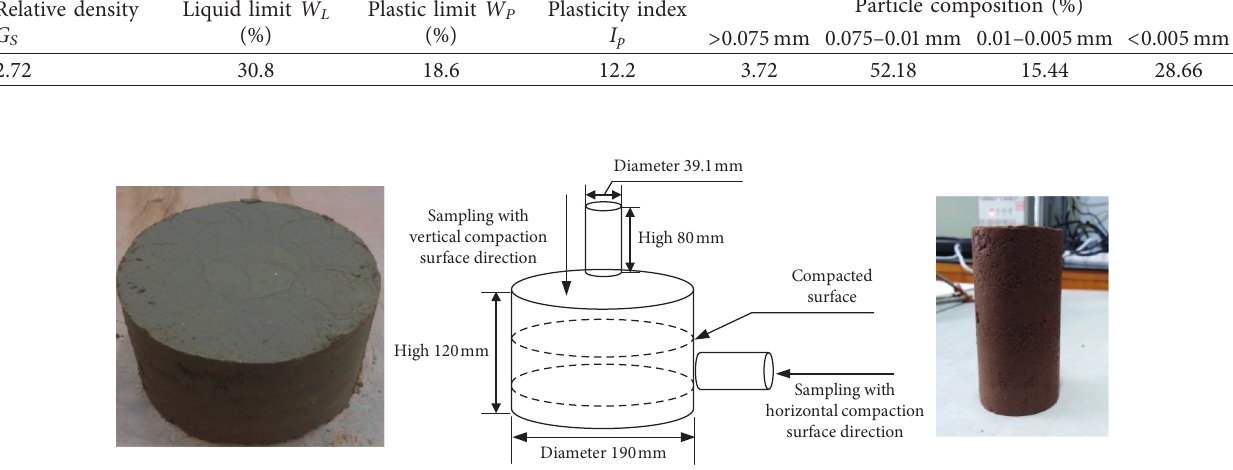
Figure 1: Samples of compacted loess and sampling direction.